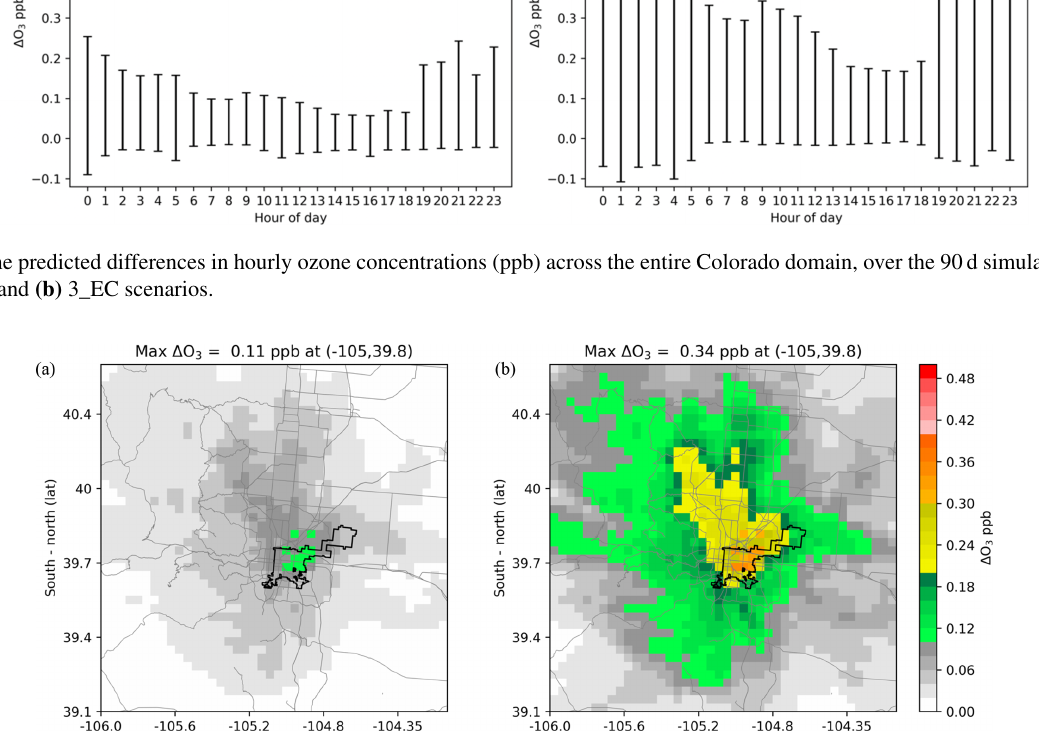
Figure 5. The predicted changes in hourly ozone concentrations for the Denver region from 06:00 to 18:000LST for all 90d of the simulation for the (a) 5_DPW and (b) 3_EC scenarios. The grey lines indicate major highways and the black line outlines Denver